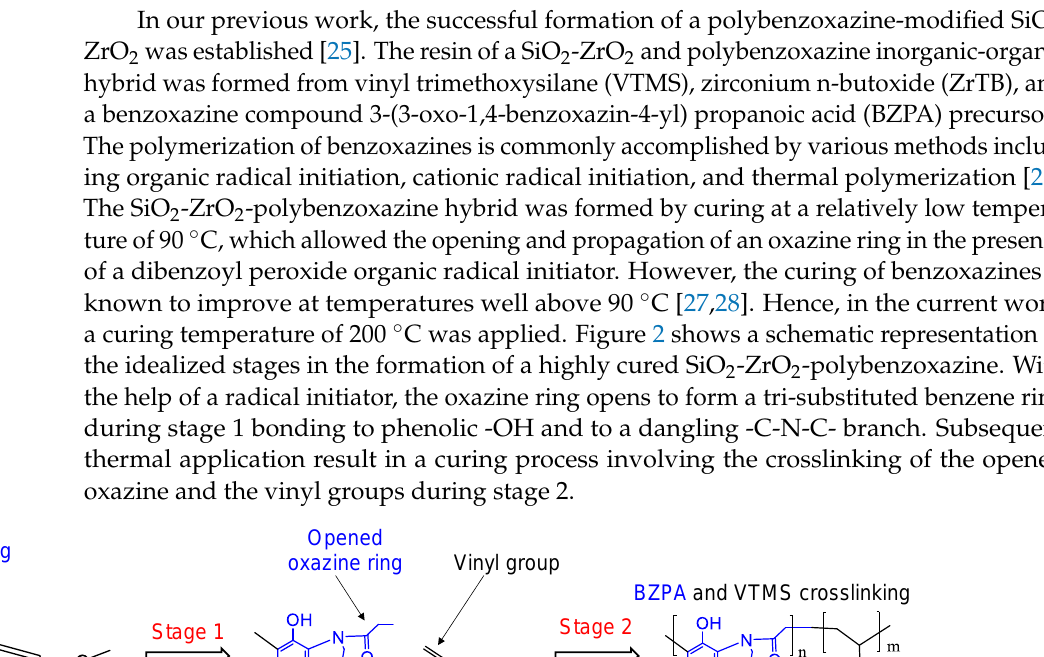
oxazine ring of BZPA in a SiO 2 -ZrO 2 -polybenzoxzine